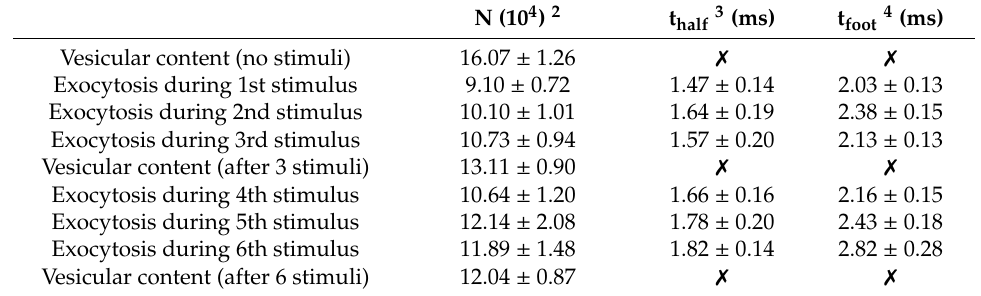
Table 1. Summary of vesicular content, exocytotic release, t half , and t foot for 6 repetitive stimuli 1